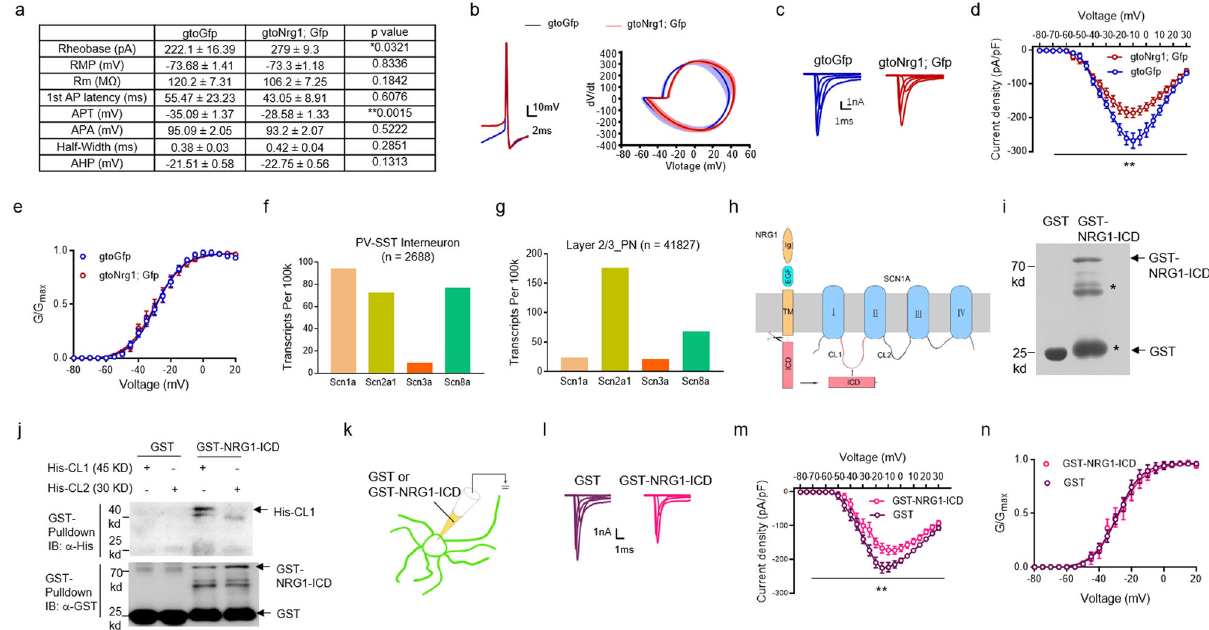
Fig. 5 Inhibition of Na v currents in GABAergic interneurons by NRG1-ICD. a Increased rheobase and depolarized action potential threshold (APT) in the FS-GABAergic interneurons of gto Nrg1 ; Gfp mice, compared with gtoGfp mice. * P = 0.0321, ** P = 0.0015, two-sided t test, n = 17 cells from fi ve gtoGfp mice, n = 21 cells from four gto Nrg1 ; Gfp mice. b Representative traces of a single AP evoked from a suprathreshold current injection (left) and corresponding phase plots (dV/dt vs voltage) (right) recorded in FS-GABAergic interneurons from gtoGfp and gto Nrg1 ; Gfp mice. c Reduced Na + current density in GABAergic interneurons from gto Nrg1 ; Gfp PFC. Representative current traces of Na v channels in GABAergic interneurons from gto Nrg1 ; Gfp and gtoGfp mice. Currents were elicited by step depolarizations from − 80 to + 30 mV in 5 mV increments from a holding potential of − 80 mV. The tracts shown are for depolarizations from − 80 to + 20 mV. d I/V curves of Na v channel activation in GABAergic interneurons from gto Nrg1 ; Gfp and gtoGfp mice. **Genotype F (1, 28) = 8.264, P = 0.0076, two-way ANOVA, n = 13 cells from three gto Nrg1 ; Gfp mice, n = 17 cells from four gtoGfp mice. Data are presented as mean values + / − SEM. e Similar voltage-dependent activation curves of Na v channels in GABAergic interneurons from gto Nrg1 ; Gfp and gtoGfp mice. Genotype F (1, 28) = 0.023, P = 0.879, two-way ANOVA, n = 13 cells from three gto Nrg1 ; Gfp mice, n = 17 cells from four gtoGfp mice. Data are presented as mean values + / − SEM. f Transcriptional levels of Scn1a is higher than Scn2a1, Scn3a, and Scn8a in PV and SST-positive GABAergic interneurons ( n = 2688 cells). Shown are transcripts of Scn genes per 100 k total transcripts from single-cell RNA sequencing. g Transcriptional levels of Scn1a were lower than Scn2a1 and Scn8a in layer 2/3 PN ( n = 41827 cells). Shown are transcripts of Scn genes per 100 k total transcripts from single-cell RNA sequencing. h Diagram showing the structure of SCN1A. The SCN1A protein was composed of four transmembrane domains (I – IV) and two major cytoplasmic loops (CL1 and CL2). The NRG1-ICD could interact with the CL1 of SCN1A. i Coomassie blue staining of 30 μ g GST and GST-NRG1-ICD proteins. Asterisks indicated degradation product of GST-NRG1-ICD proteins. Four independent experiments were repeated to get similar